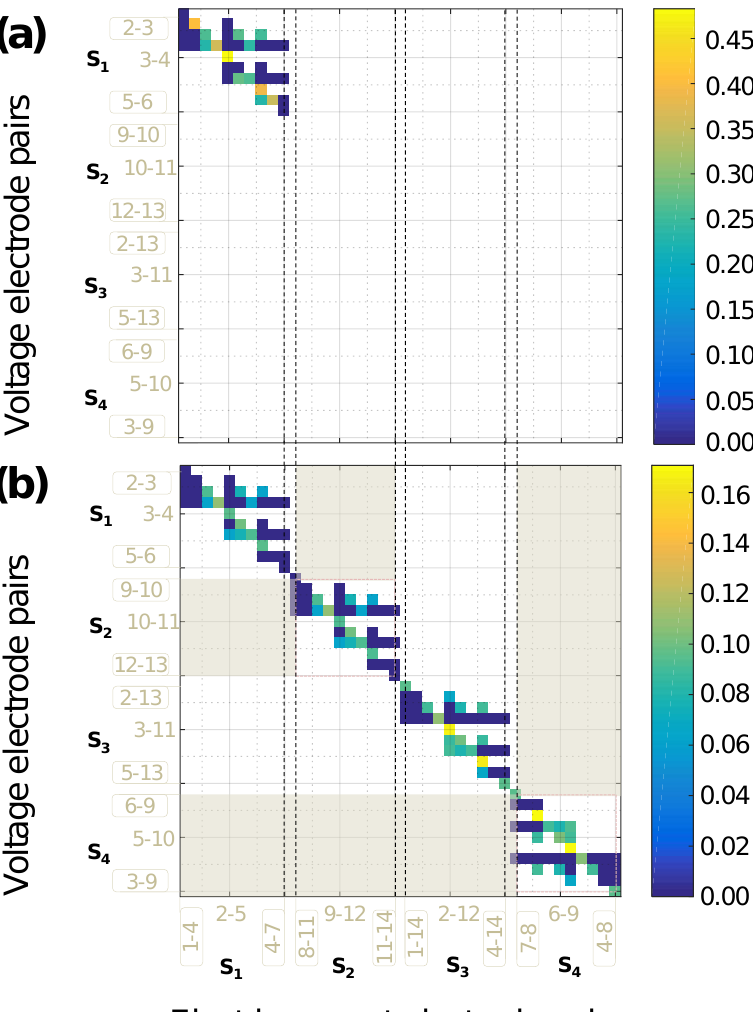
Figure 6. Results of Effective Independence on four-probe schemes on [( 0/90 ) 4 ] s layup using ( a ) one-sided electrodes and ( b ) two-sided electrodes. Column sections show groups for surface resistance ( S 1 , S 2 ) and oblique resistance ( S 3 , S 4 ) measurements. Cells in dark blue indicate eliminated combination with low EI